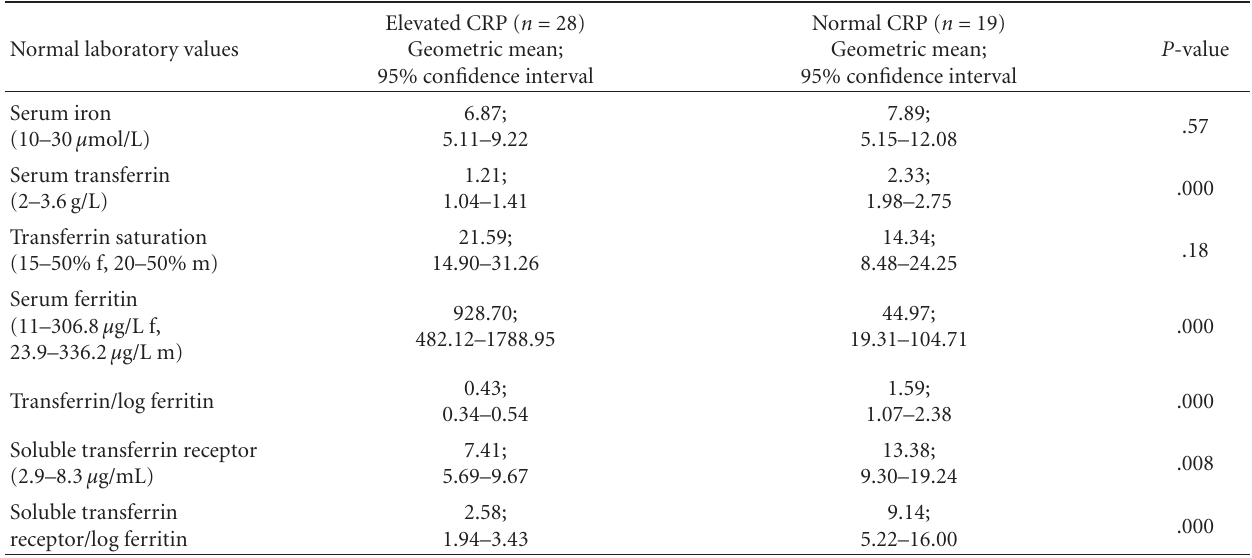
Table 3: Serum iron markers and soluble transferrin receptor for patients with elevated C-reactive protein and patients with normal C- reactive protein.